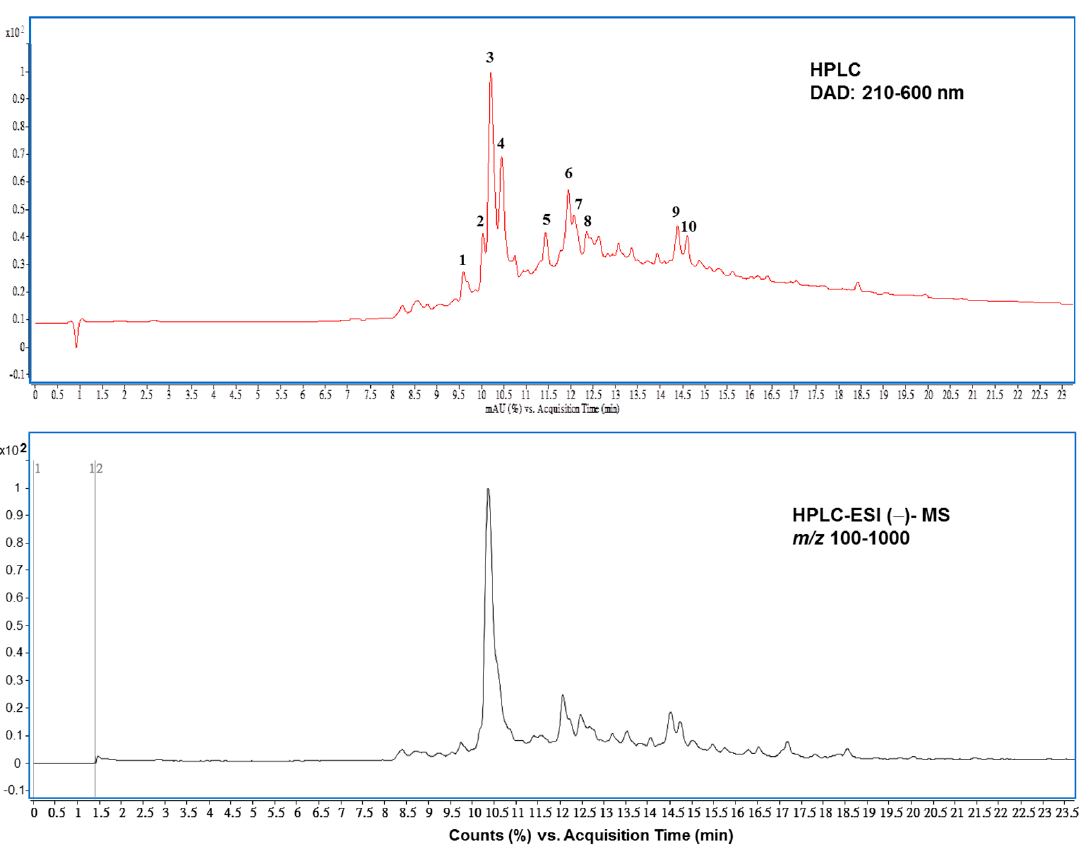
Figure 2. Representative total ion chromatogram of HPLC–MS spectrometry in the negative ionization mode ( bottom ), and HPLC ( top ) profile in the analyses of polyphenol-enriched hawthorn fruit extract (PEHE). Peak numbers refer to Table